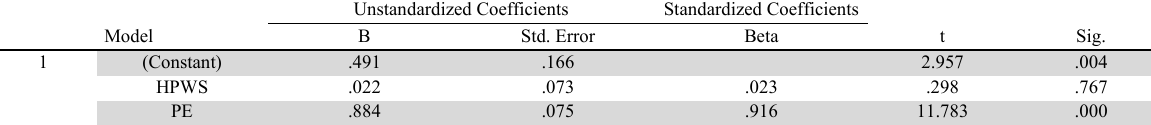
Regression analysis HPWS SEP and PE as